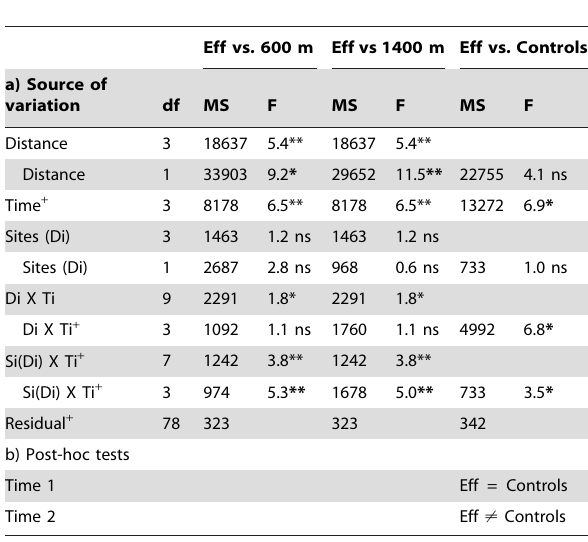
Table 7. Multivariate analyses on the structure of assemblages in different sites in all sampling